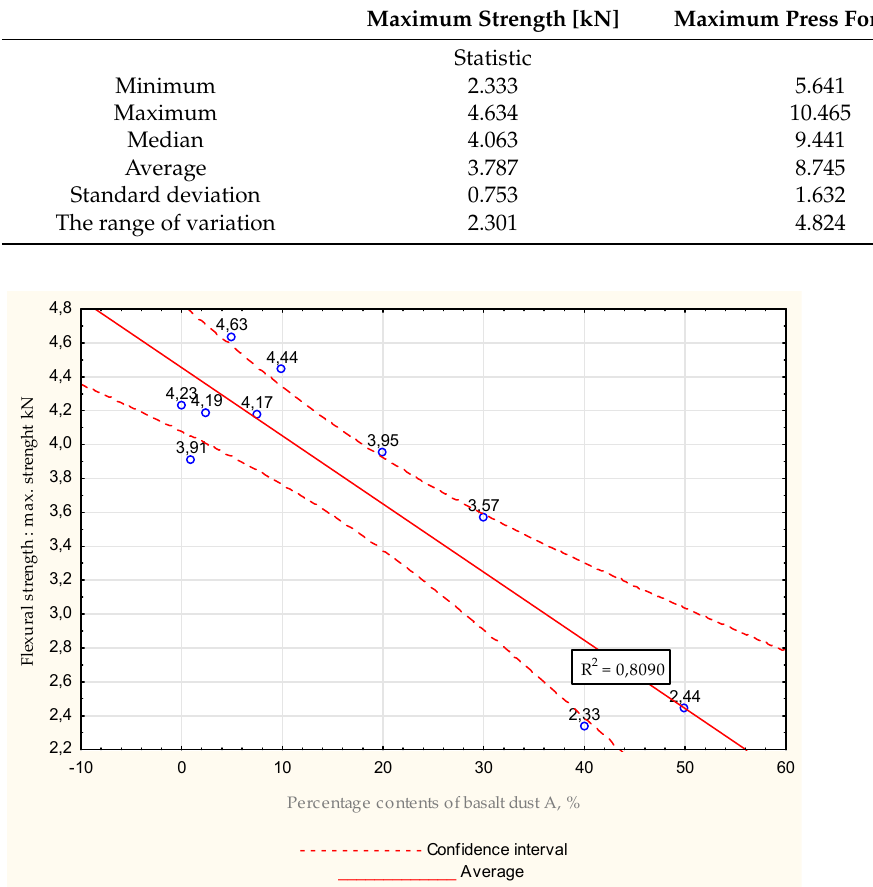
Figure 15. Average values received during flexural strength tests for water − mix ratio = 0.5, maximal strength.